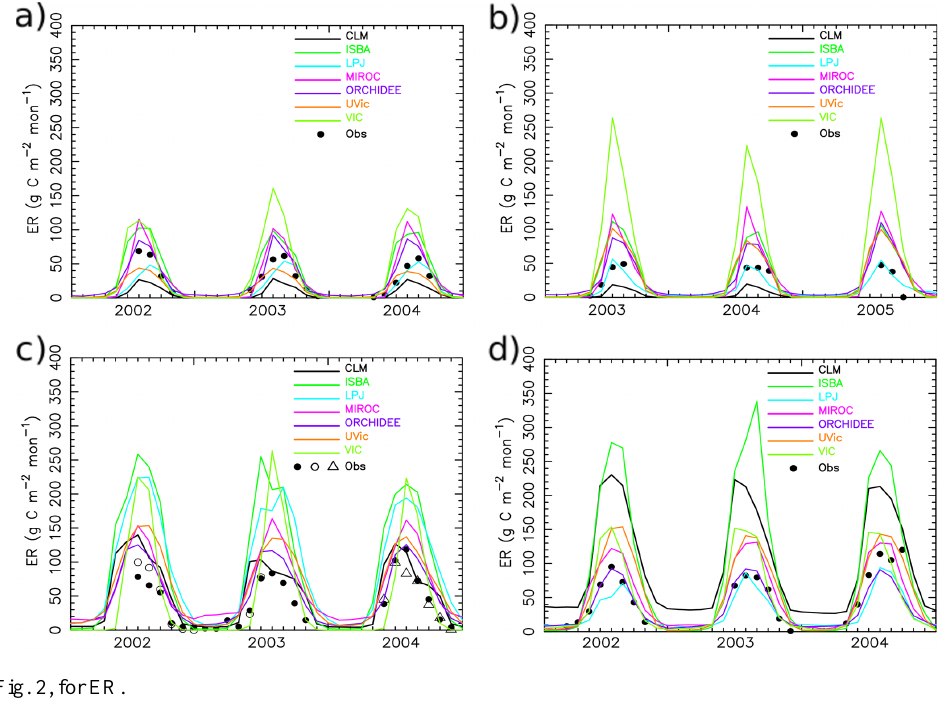
Figure 3. As in Fig. 2, for ER.